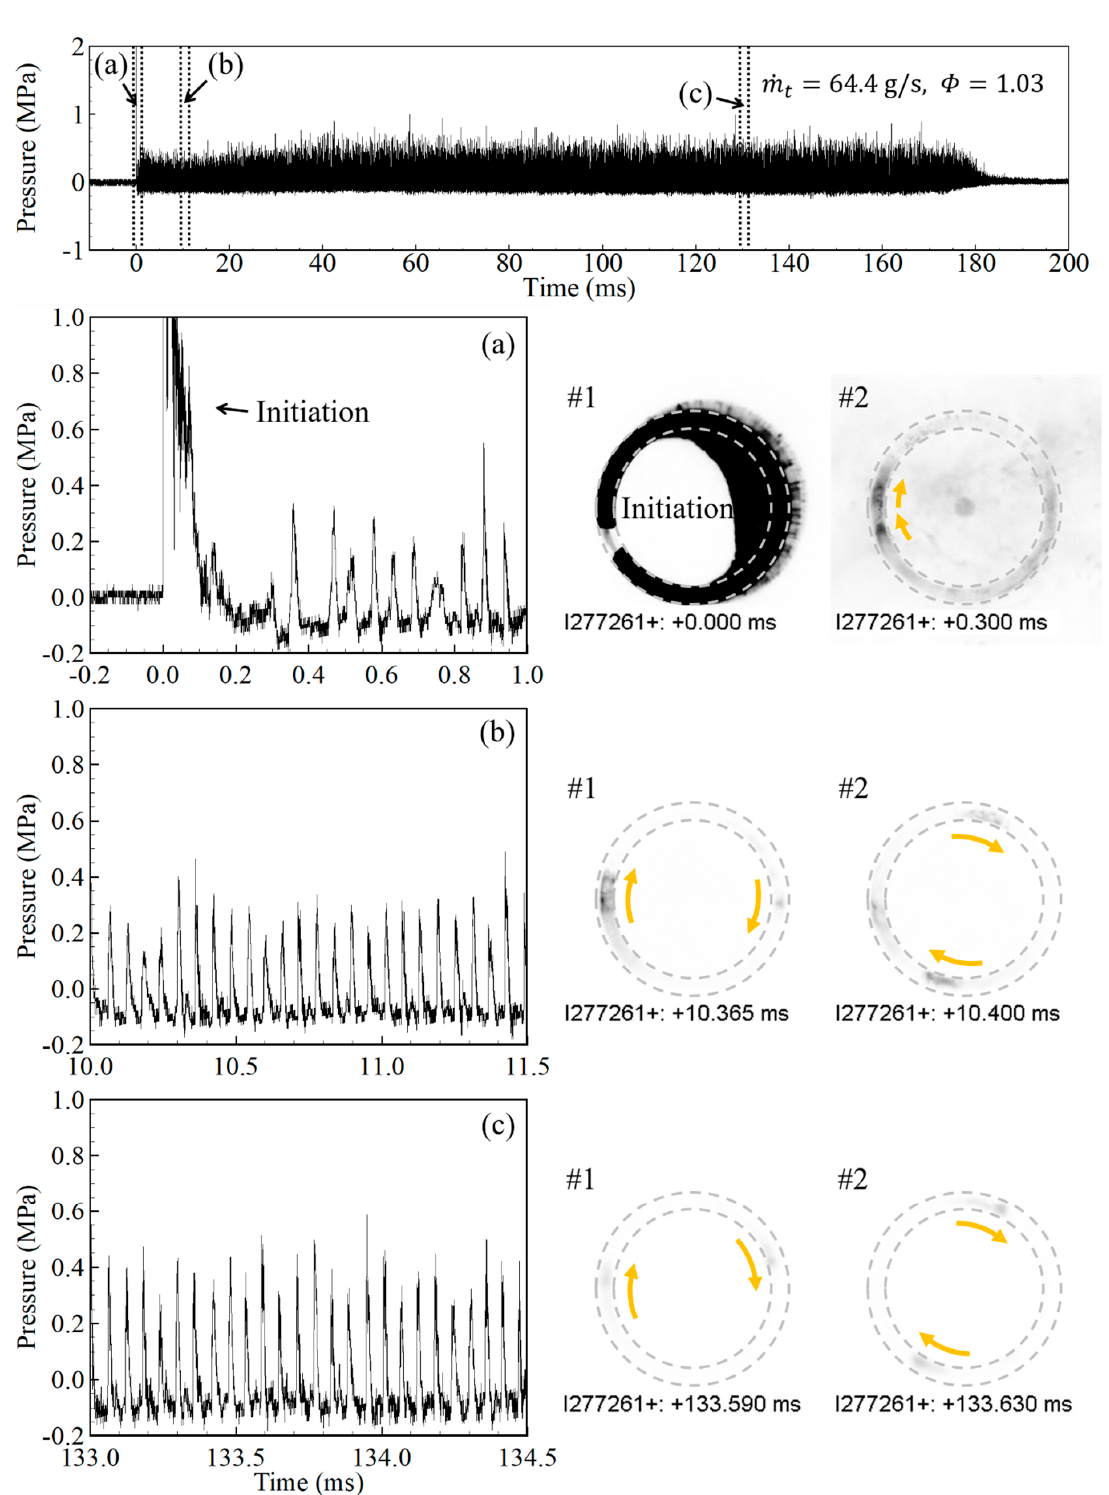
. m t = 64.4 g/s, Φ = 1.03: ( a ) detonation initiation and